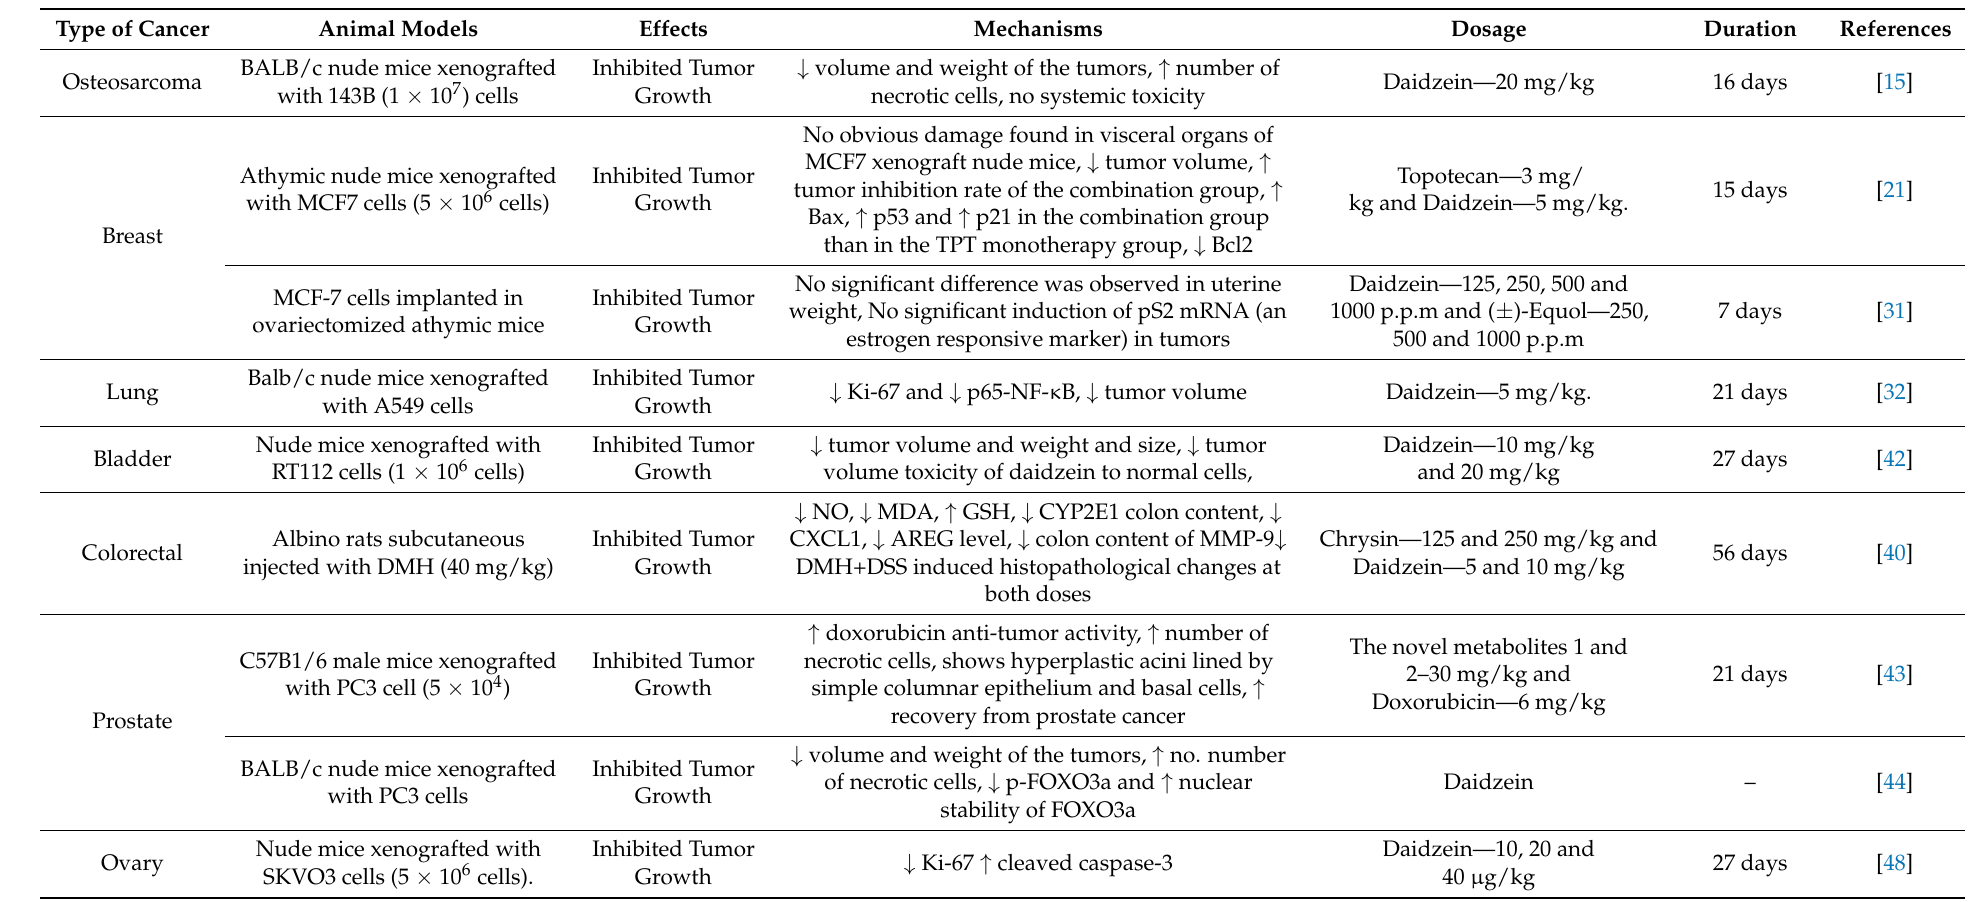
Table 2. Anticancer effects of daidzein and its metabolites including equol based on in vivo